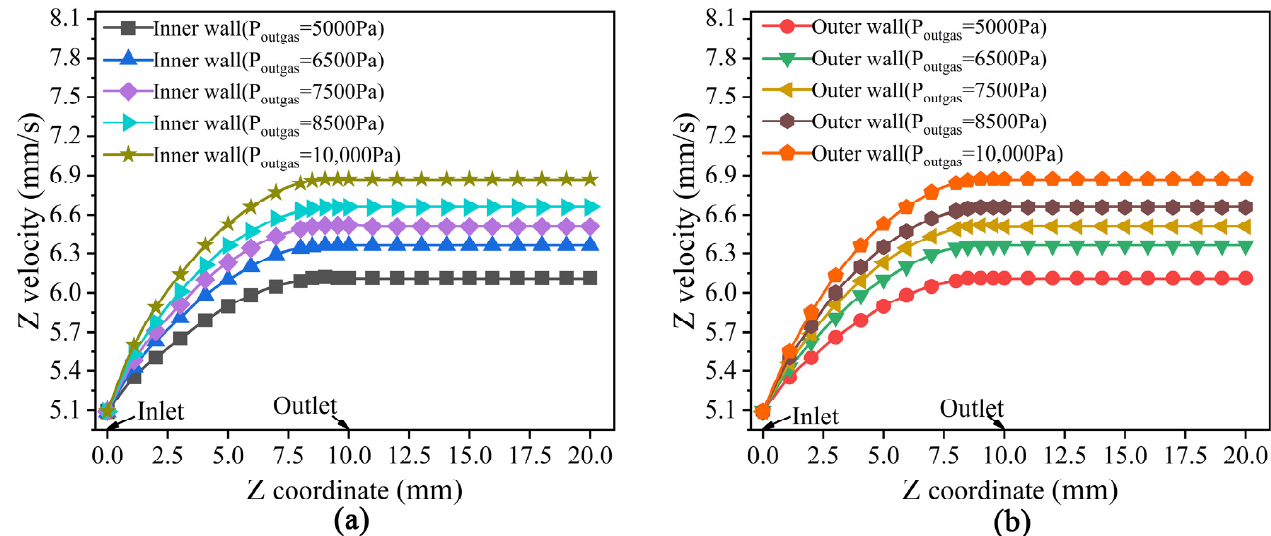
Figure 5. The distribution of melt Z velocity under different pressure of the outer gas cushion layer. ( a ) Z velocity at inner surface of the melt; ( b ) Z velocity at outer surface of the melt.